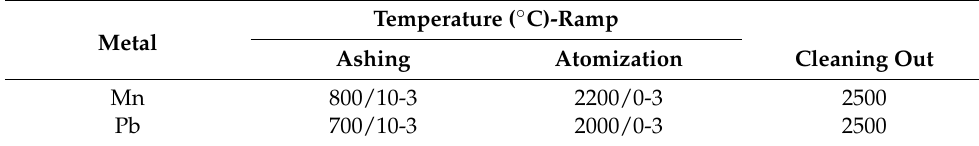
Table 2. Furnace graphite